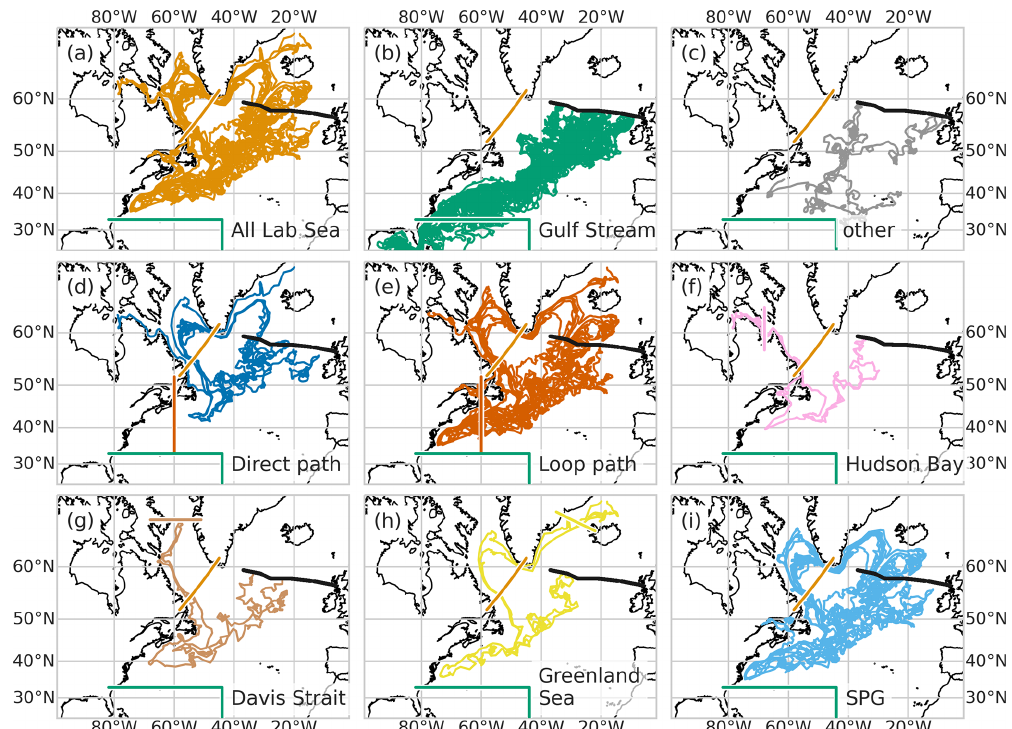
Figure 3. Example particle paths showing the identification of particle sources and pathways. The black line is the section of OSNAP E where particles are released for backward tracking. The coloured straight lines delimit the source regions and pathways: orange – Labrador Sea, green – Gulf Stream, dark orange – the loop pathway, pink – Hudson Bay, brown – Davis Strait, and yellow – Greenland Sea. Panels (a–c) show the main source regions: (a) the Labrador Sea, (b) the Gulf Stream, (c) no source determined – “other” source. Panels (d, e) show further subsets of (a) , highlighting different pathways from the Labrador Sea to OSNAP E : (d) the direct path (tracks do not cross the dark orange line at 60 ◦ W), (e) the loop path (tracks cross and recross the dark orange line). Panels (f–i) show an alternative subset of pathways of Labrador Sea origin (a) , classifying particle tracks by source regions further upstream of the Labrador Sea: (f) Hudson Bay, (g) Davis Strait, (h) Greenland Sea, and (i) particles recirculating in the subpolar